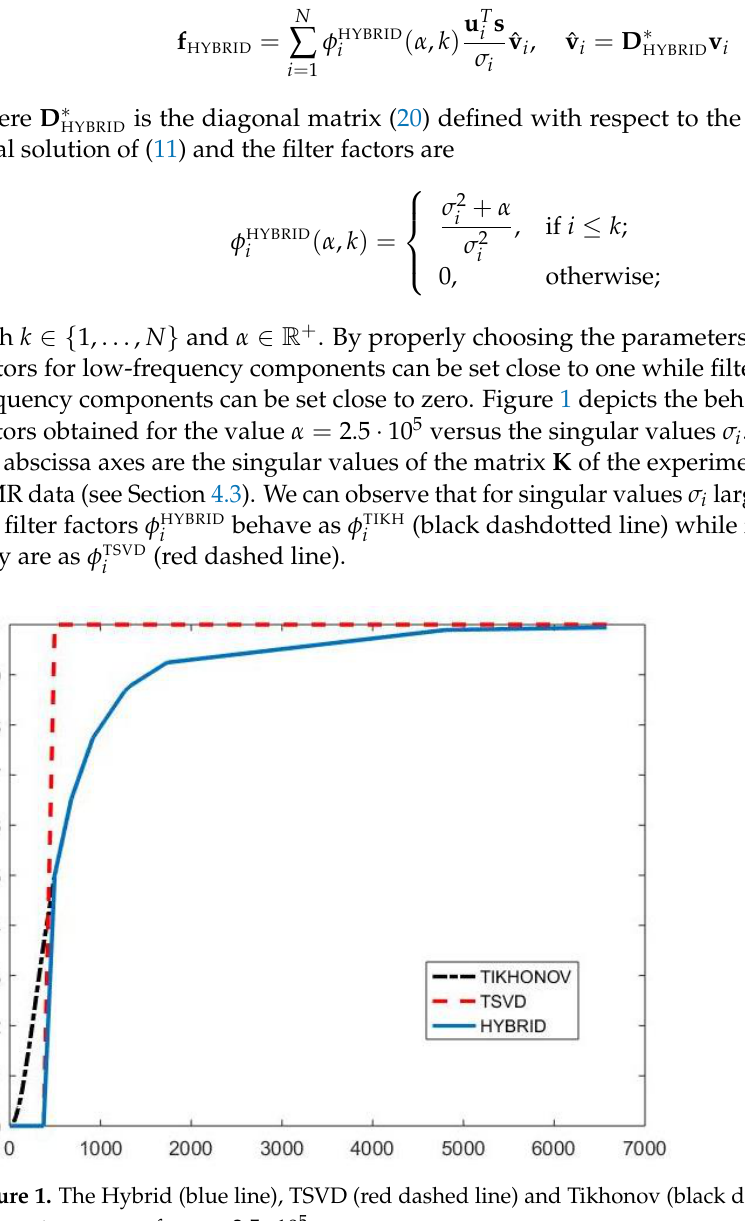
Figure 1. The Hybrid (blue line), TSVD (red dashed line) and Tikhonov (black dashdotted line) filter factors φ i versus σ i for α = 2.5 · 10 5